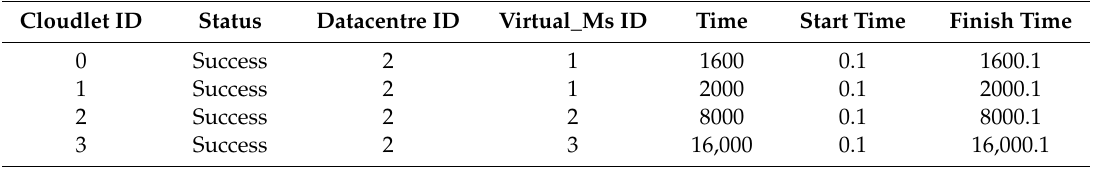
Table 9. Outputs of default CloudSim, second